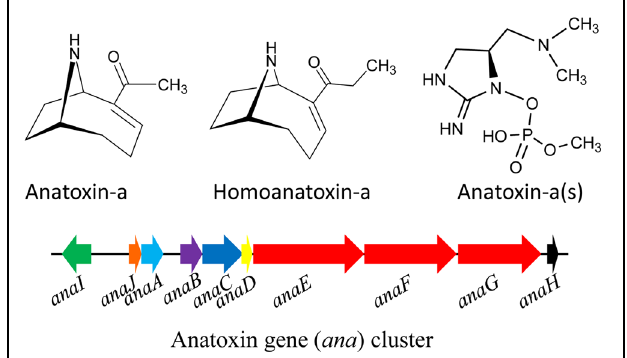
FIGURE 4 | Chemical structure of anatoxins and its biosynthetic gene ( ana ) cluster in the cyanobacterium Oscillatoria sp. PCC6506. Green – transporter, orange – cyclase, light blue – thioesterase, purple – oxidase, blue- adenylation protein, yellow – acyl carrier protein, red – polyketide synthase, black – transposase (adapted from Rantala-Ylinen et al., 2011; Méjean et al., 2014; Gene cluster not drawn to scale).